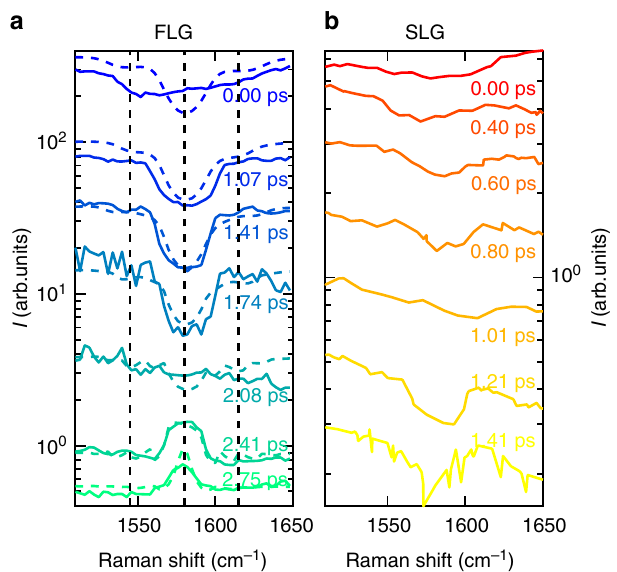
Fig. 3 Graphene CARS spectra. CARS spectra of a FLG and b SLG as a function of Raman shift ~ ν (cid:3) ~ ν at different Δ T between the beams at tunable P ð Þ ω fi xed ω fi ts to the data using Eq. (1) and S and P . In a , colored dashed lines are the nonlinear polarization obtained from Eqs. (19) and (20). Vertical black ~ ν dashed lines indicate three energies ð ~ ν 1545 ; 1576 ; 1607 cm (cid:3) 1 Þ , 1 ; 2 ; 3 (cid:3) P ¼ taken as reference for the FLG CARS images in Fig.